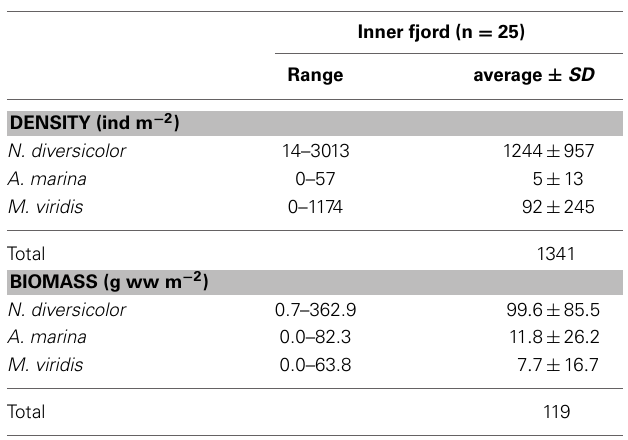
Table 2 | Range and area-wide average ( ± SD ) density and biomass of Nereis diversicolor , Arenicola marina and Marenzelleria viridis obtained during 2008 and 2010 surveys in the inner part of Odense Fjord (data derived from Delefosse and Kristensen, 2012 and Kristensen et al.,